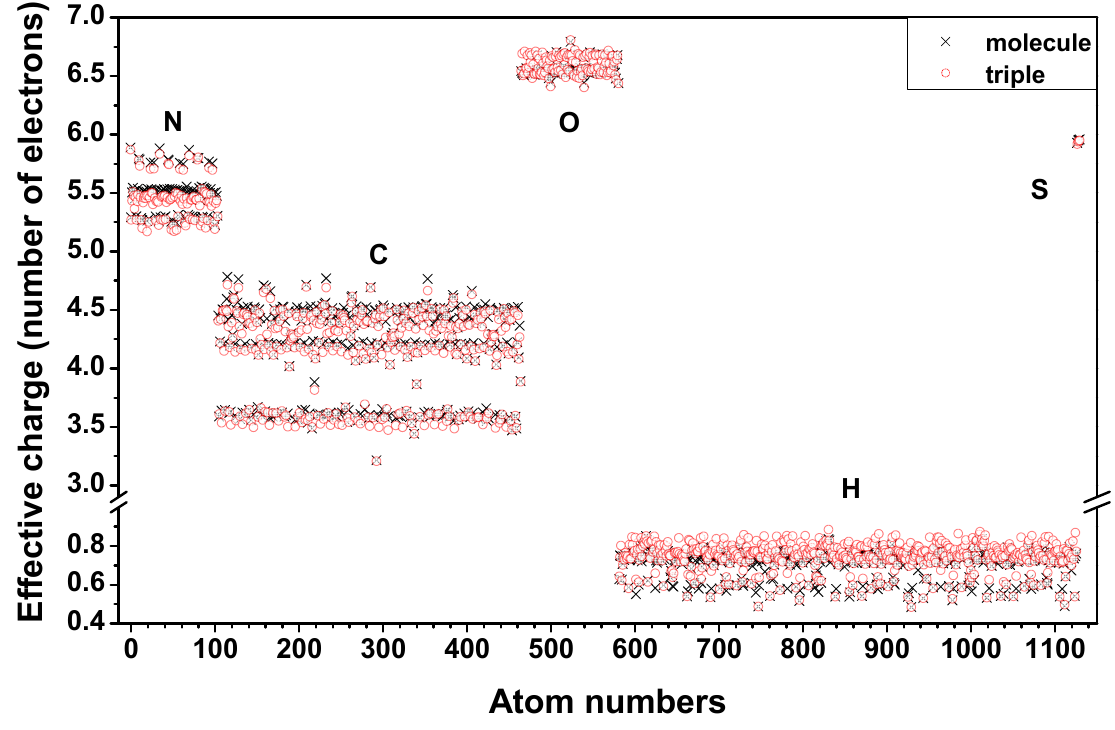
Figure 9. (Color on-line) Comparison of effective charges Q* (electrons) from SCF calculation of three individual chains and the triple-helix using AAPM. Red circles represent triple-helix values and black x’s represent values from chain 1 ( α 2), 2 ( α 1) or 3 ( α 1) with atoms aligned with those of the